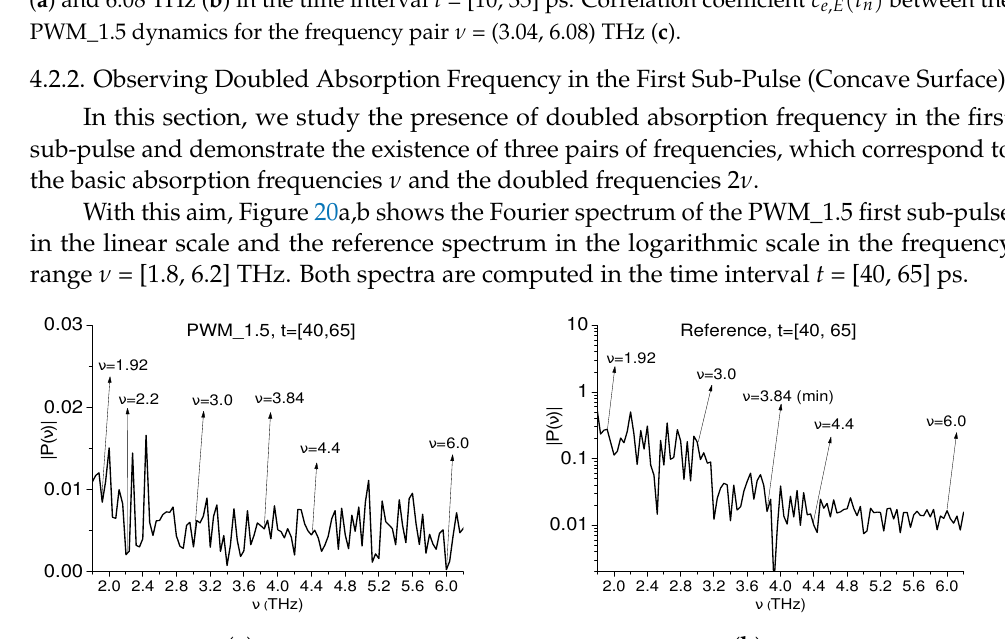
ν = 3.84 THz (also as at the frequencies ν = 4.4, 6.0 THz) may occur because of the